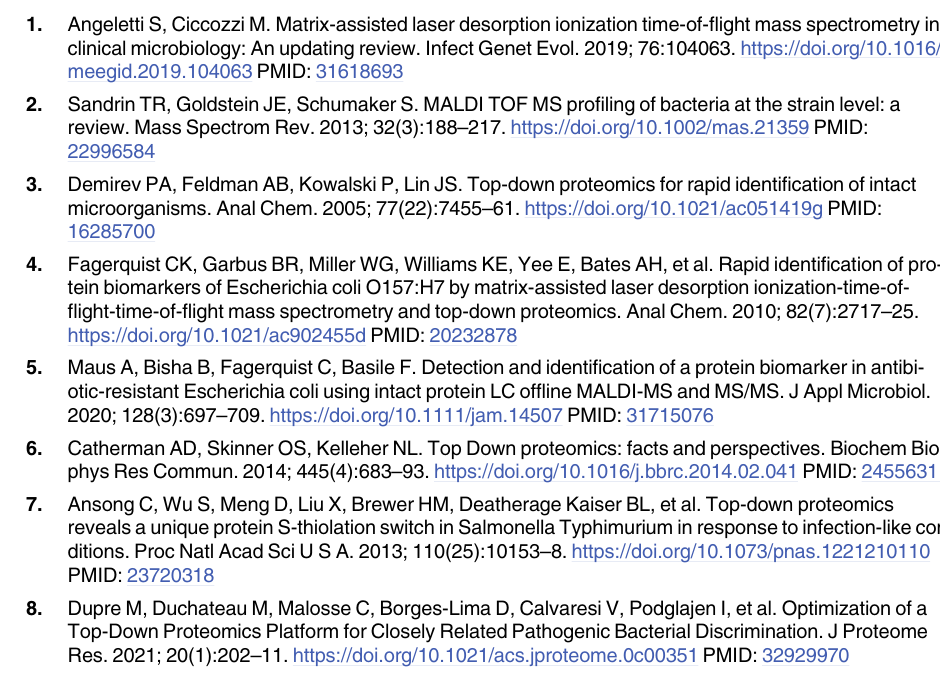
S1 Fig. MS of sample supernatant of E . coli O113:H21 strain RM7806 cultured overnight on LBA supplemented with 400 ng/mL of MMC. Protein ion at m/z 9779 (marked with star) was analyzed by MS/MS (Fig 4, bottom panel). S2 Fig. MS of sample supernatant of E . coli O113:H21 strain RM7807 cultured overnight on LBA supplemented with 400 ng/mL of MMC. Insert shows an expanded m/z region. Pro- tein ions labeled HdeA and HdeB are highly conserved acid stress proteins previously identi- fied in other E . coli strains. Protein ion at m/z 9778 (marked with star) was analyzed by MS/ MS (Fig 7, middle